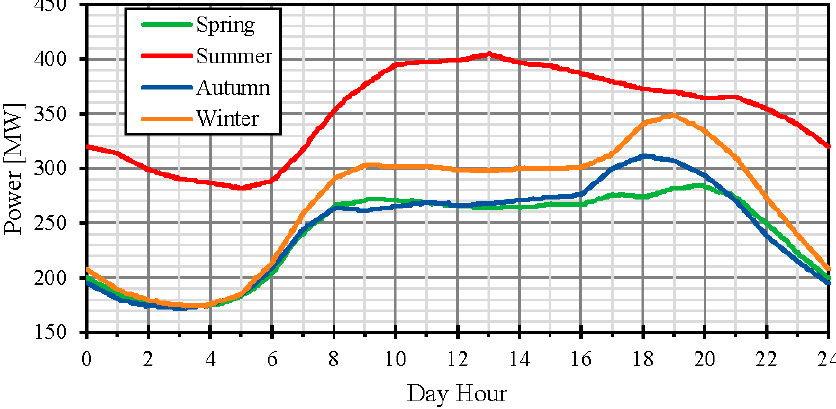
Figure 5. Average daily load charts per season (2012–2014) [20].